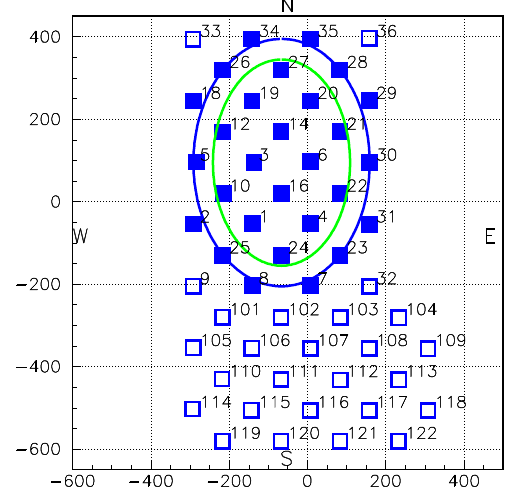
Figure 3. Layout of TAIGA-HiSCORE station 2018 – 2019. Filled squares - version of 2017, open squares - new stations. Black ellipse limits the e ff ective area for fitted events, green el- lipse limits the e ff ective area for the gravity center events.